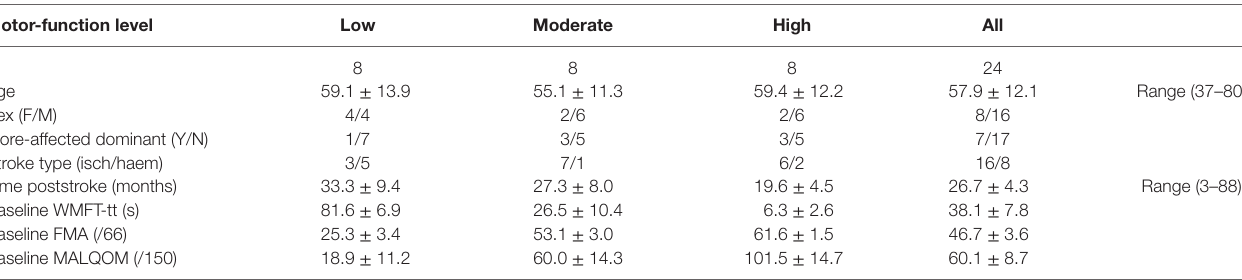
Table 1 | Baseline patient